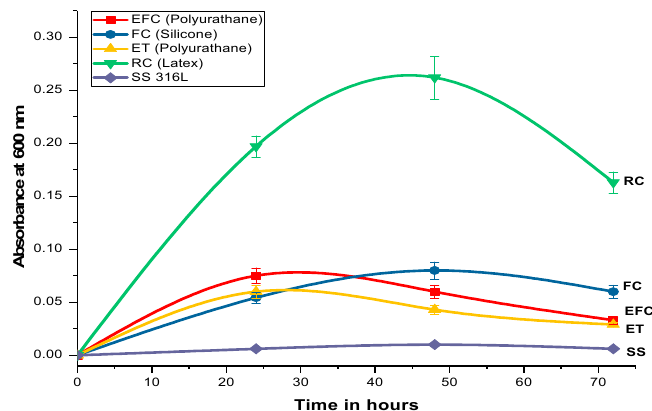
Figure 1. Graphical pattern of E. coli biofilm formation over different materials.